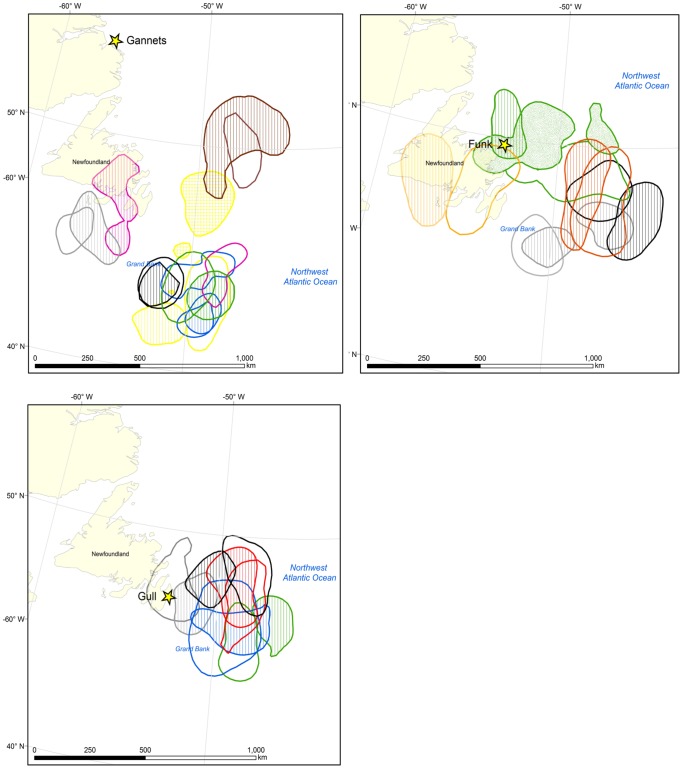
Repeated core winter areas of Common Murres.Examples of core winter areas (50% KHR) of individual Common Murres from three colonies (Gannet, Funk, and Gull islands), tracked across consecutive years. Colors note repeated observations for the same individual, with cross-hatching to identify the difference between years. To facilitate interpretation in areas of high kernel overlap, only a selection of repeat tracks is shown.